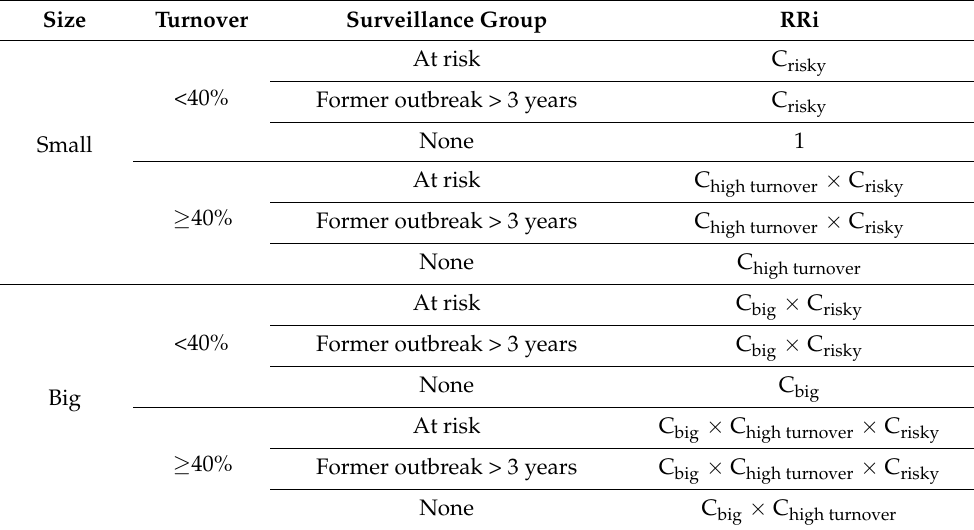
Table 1. Calculation of the relative risk of TB infection for each herd category (RRi) used in the scenario tree modeling ante-mortem TB surveillance on a